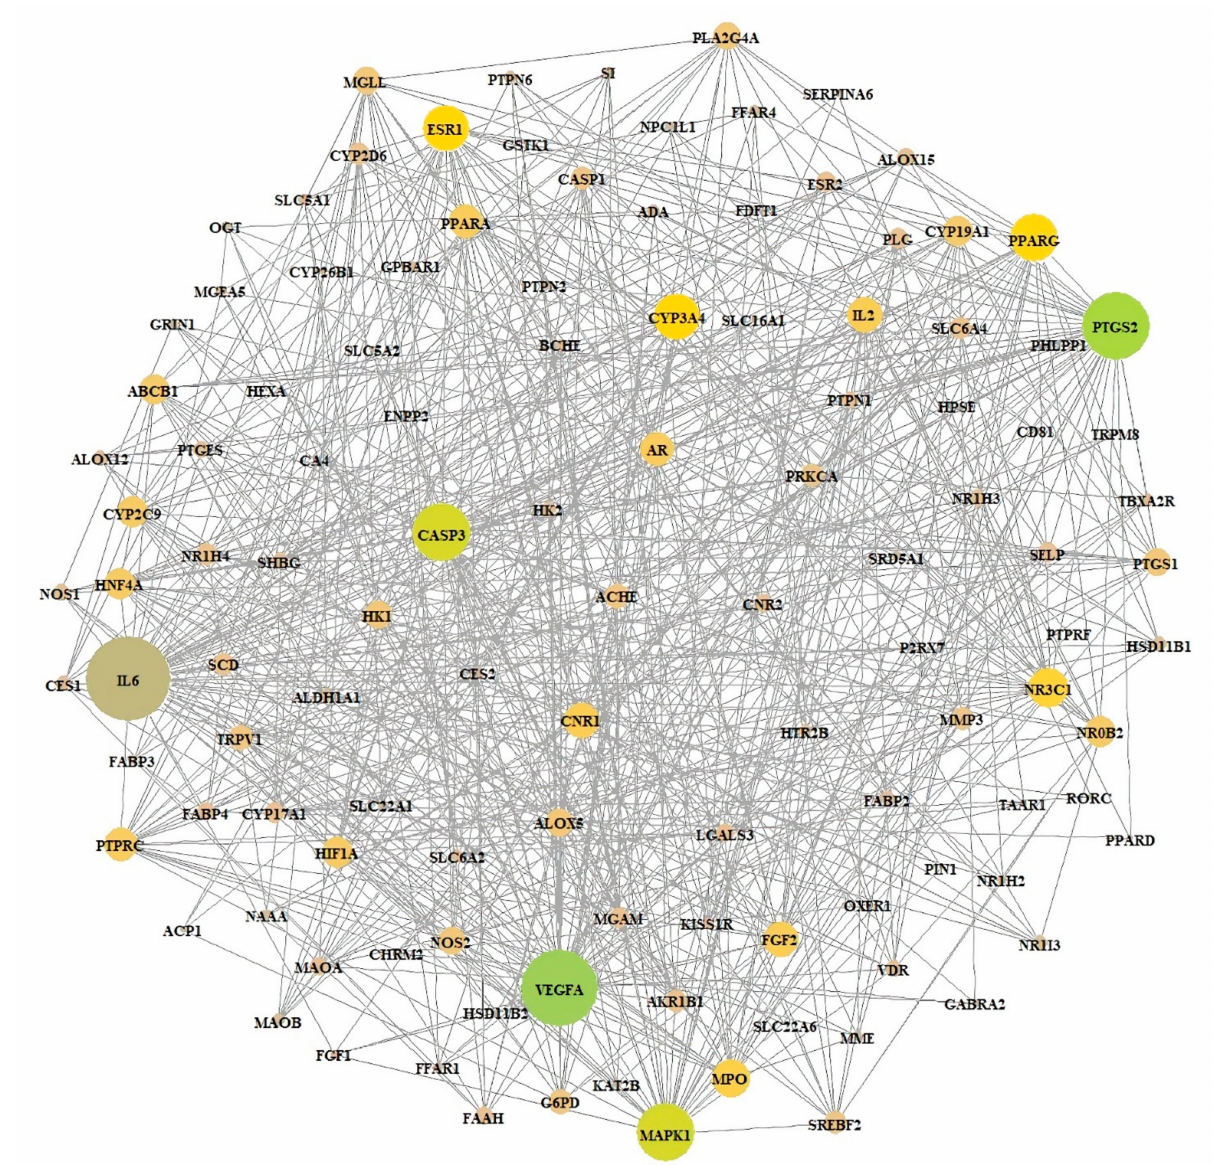
Figure 4. PPI networks (116 nodes and 674 edges). The size of circles stands for the degree of